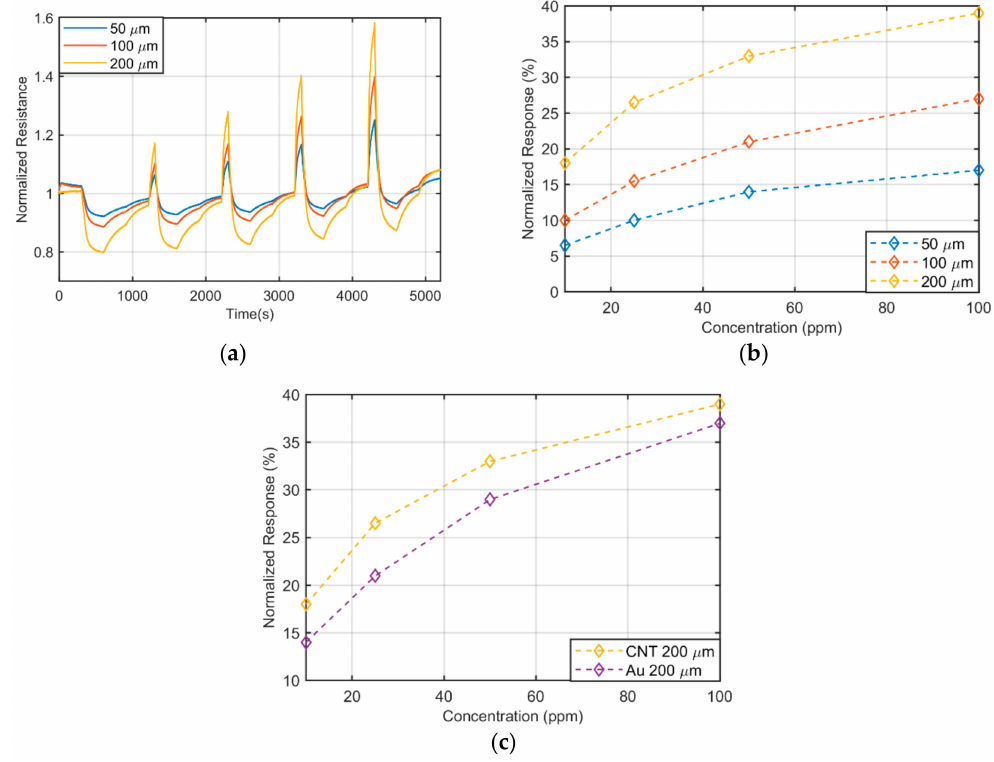
Figure 3. ( a ) Time response of fully transparent sensor to NH 3 ; ( b ) calibration curves of fully transparent sensor for NH 3 ; ( c ) calibration curves towards ammonia for 200 µ m spacing for Au and CNT electrodes.